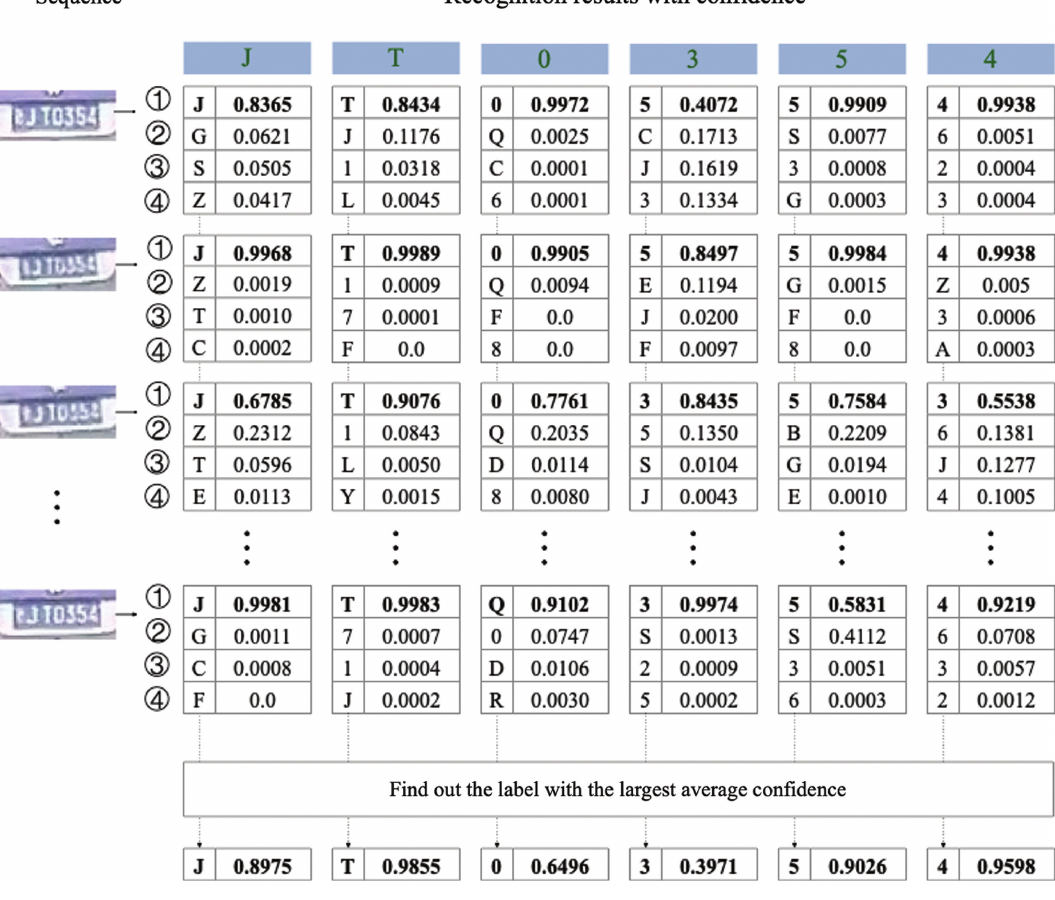
Figure 5: Integration Based on Confidence.